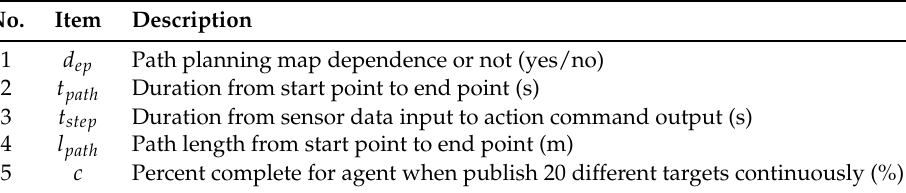
Table 1. Evaluation